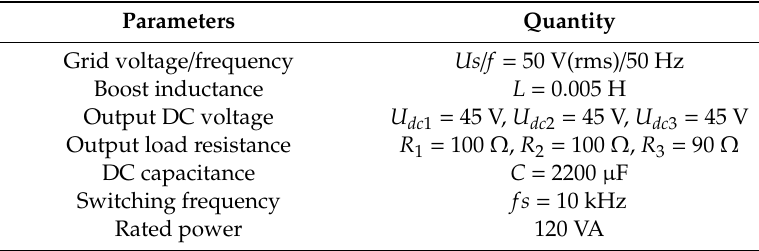
Figure 7. Scaled-down experiment prototype. Table 4. Specifications of the